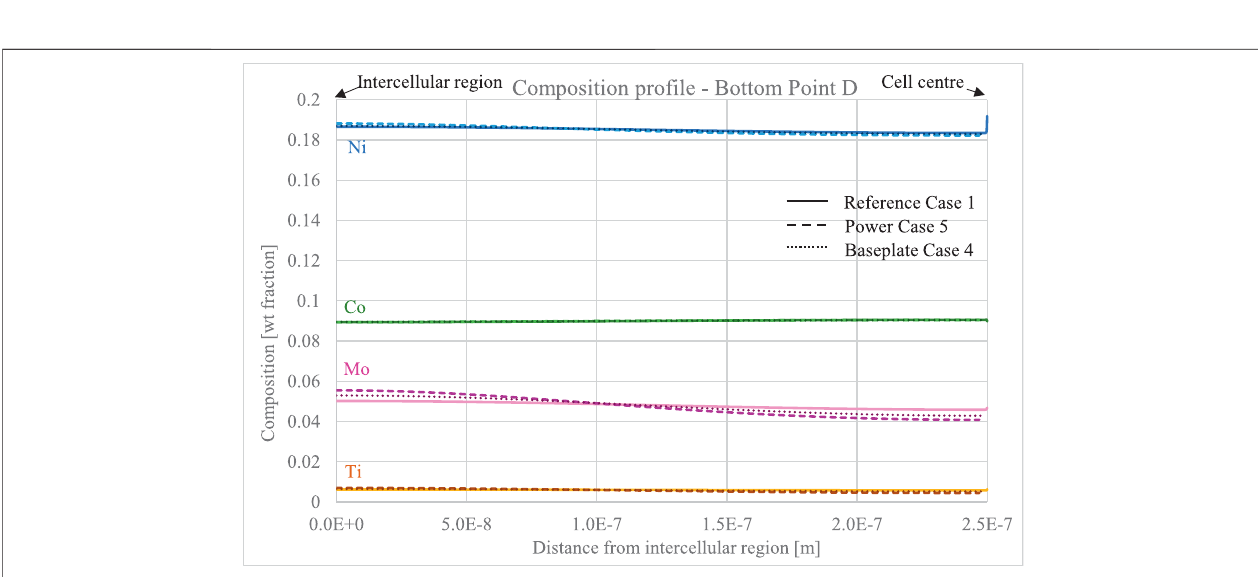
FIGURE 11 | Calculated composition pro fi le for point D for Cases 1, 4, and 5. Dendrite/cell center at the right side and interdendritic/intercellular region to the left.